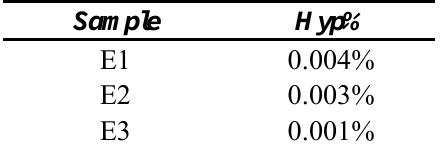
Table 2. Total hypericins content in St. John’s Wort oil extracts.